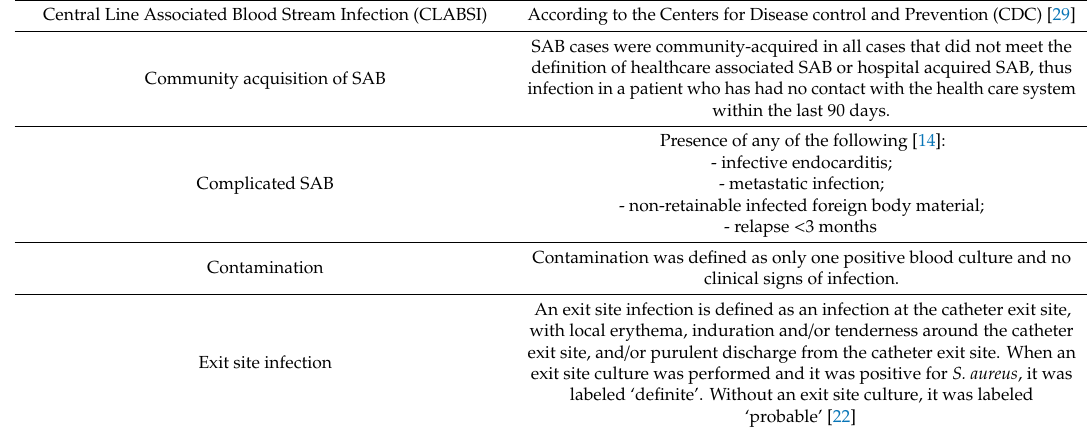
Table A1. Additional